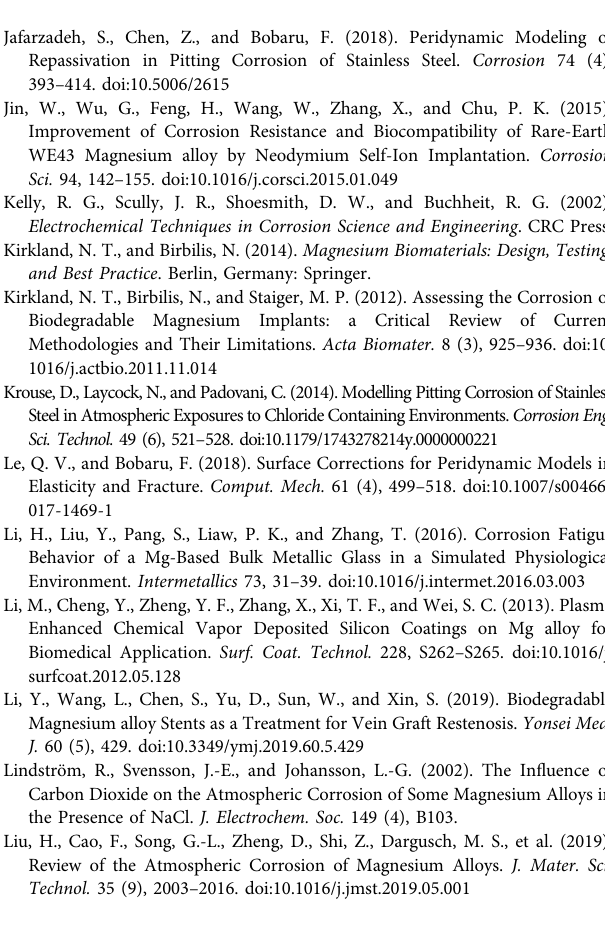
Supplementary Figure S1 | STL fi les of magnesium alloy specimens. Supplementary Figure S2 | Image processing procedures for quantitating the pitting characteristics. Supplementary Figure S3 | Flowchart of simulation. Supplementary Figure S4 | Experimental data of AZ61 in saline. (A) Number of pits. (B) Total projected area of pits on the surface. Supplementary Figure S5 | Comparison of results for four element sizes. (A) Convergence analysis by different grid sizes. (B) Reproducibility analysis by the same grid size. Supplementary Figure S6 | Ratio of the surface area in the